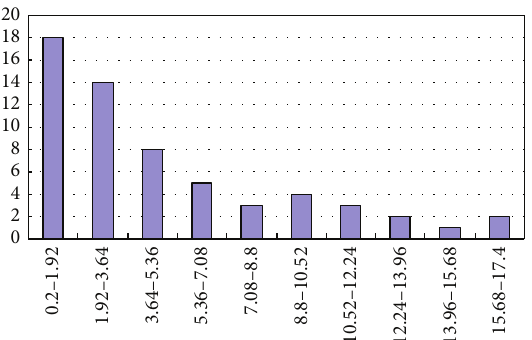
Figure 4: Theschematic diagram of a kind of frequency distribution